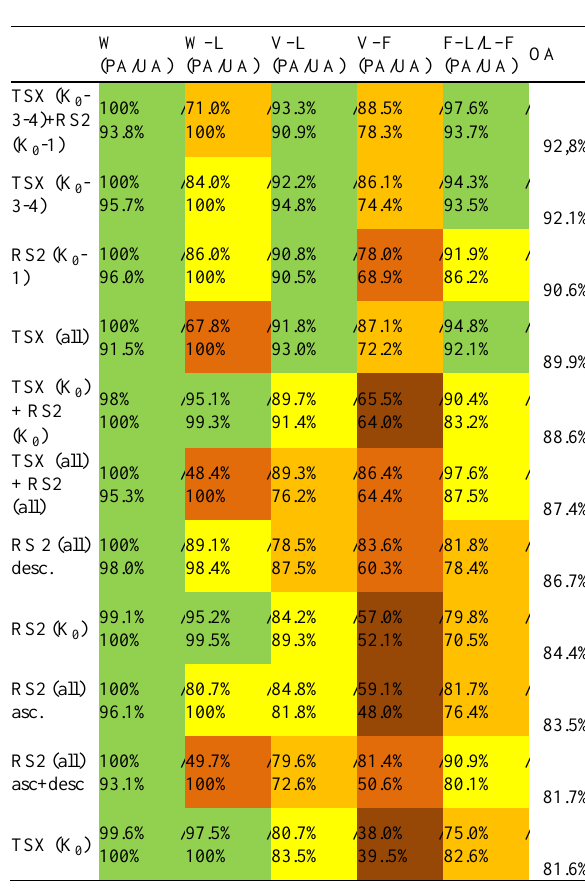
Table 2: Accuracy Assessment for the multitemporal classification of different polarimetric, frequency, and Kennaugh element combinations of the TerraSAR-X and RADARSAT-2 time series, ranked by Overall Accuracy